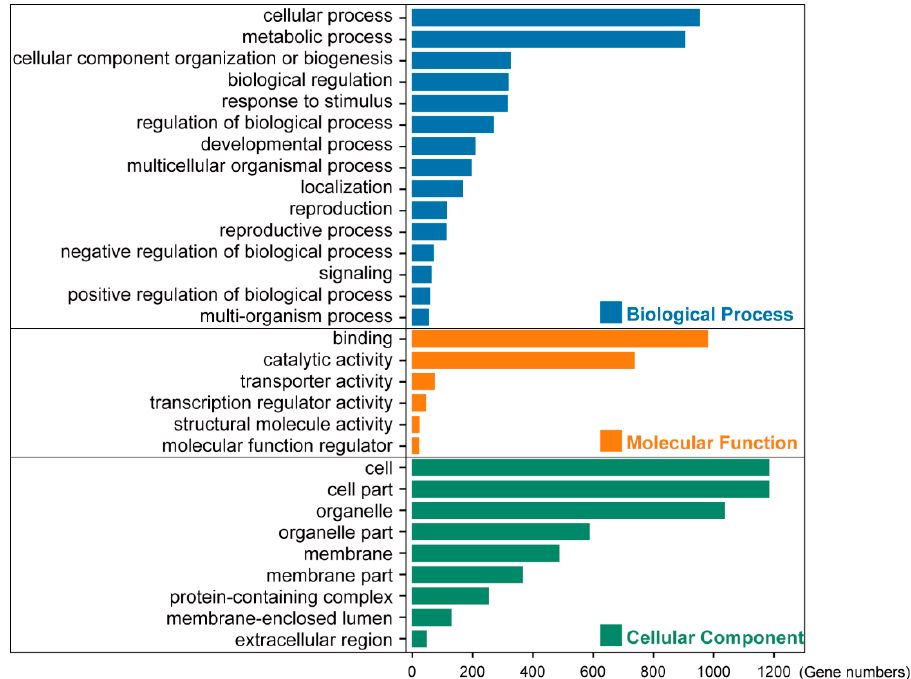
Figure 2. GO enrichment analysis 1499 genes in model plants Arabidopsis thaliana belonging to the 1785 OGs. The X-axis shows gene numbers, and the Y-axis lists the plant GO slim terms categories. Blue, orange, and green bars represent biological processes, molecular functions, and cellular components, respectively.